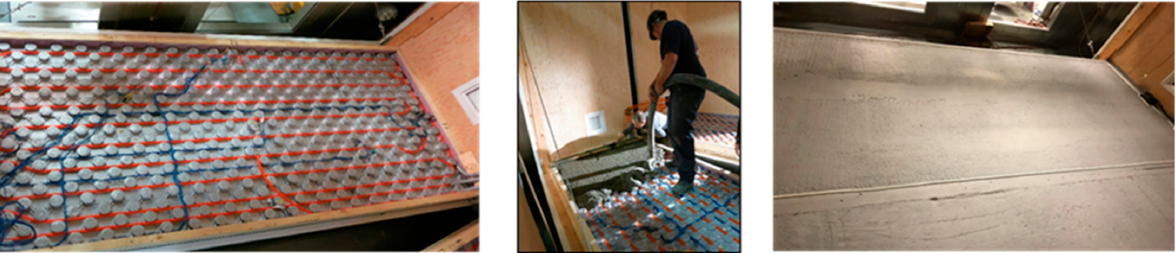
Figure 3. Radiant floor piping before ( left ), during ( middle ) and after ( right ) pouring the concrete. A mechanical room provides controlled flow rate of the fluid (propylene-glycol and water mixture) for the radiant floor. The schematic of the environmental chamber and PZTC is shown in Figure 4.